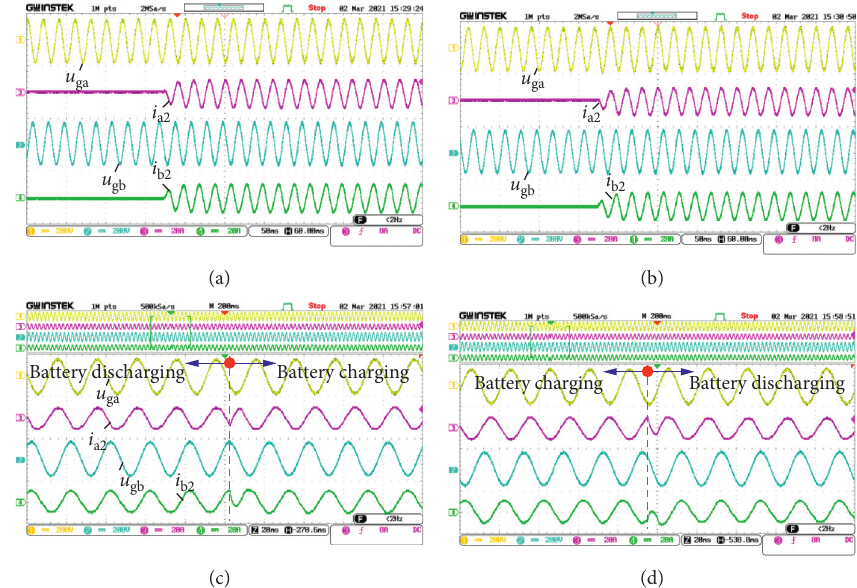
Figure 16: Experimental results of the PCS prototype. (a) Grid voltage and current waveforms for nominal discharging start-up test. (b) Grid voltage and current waveforms for nominal charging start-up test. (c) Transient waveforms when PCS changes from discharging to charging condition. (d) Transient waveforms when PCS changes from charging to discharging